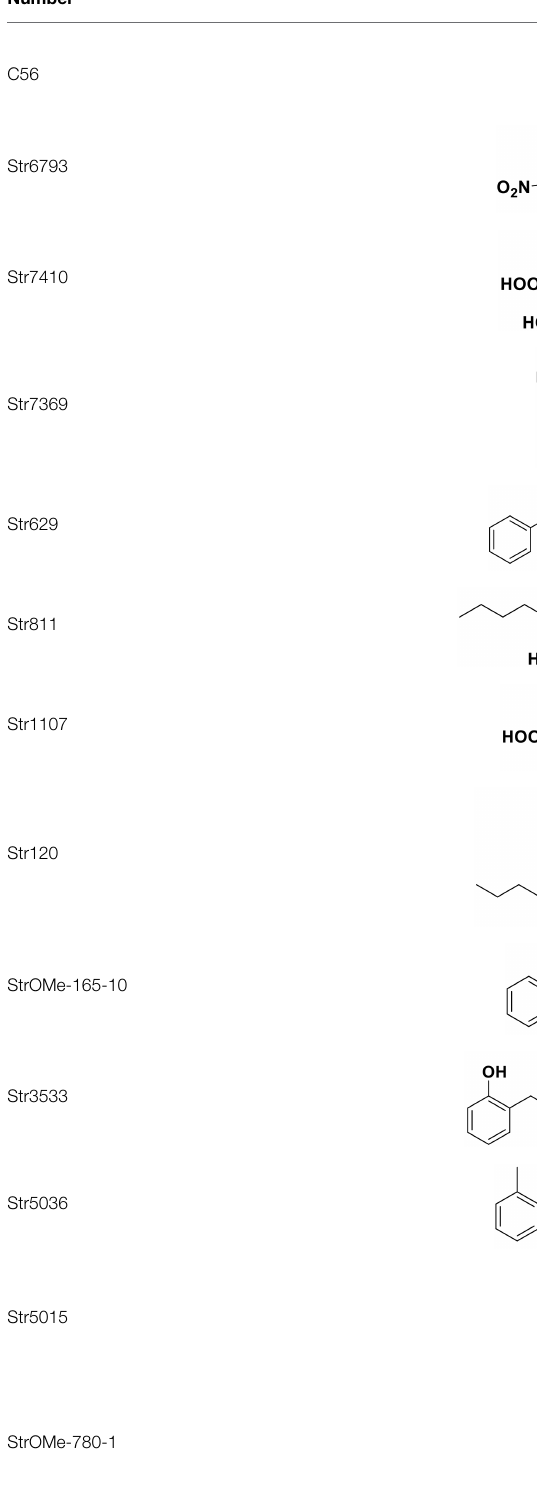
TABLE 2 | Anti- Vibrio harveyi BB170 autoinducer-2 (AI-2) quorum sensing (QS) activities of test compounds and its structure. Number